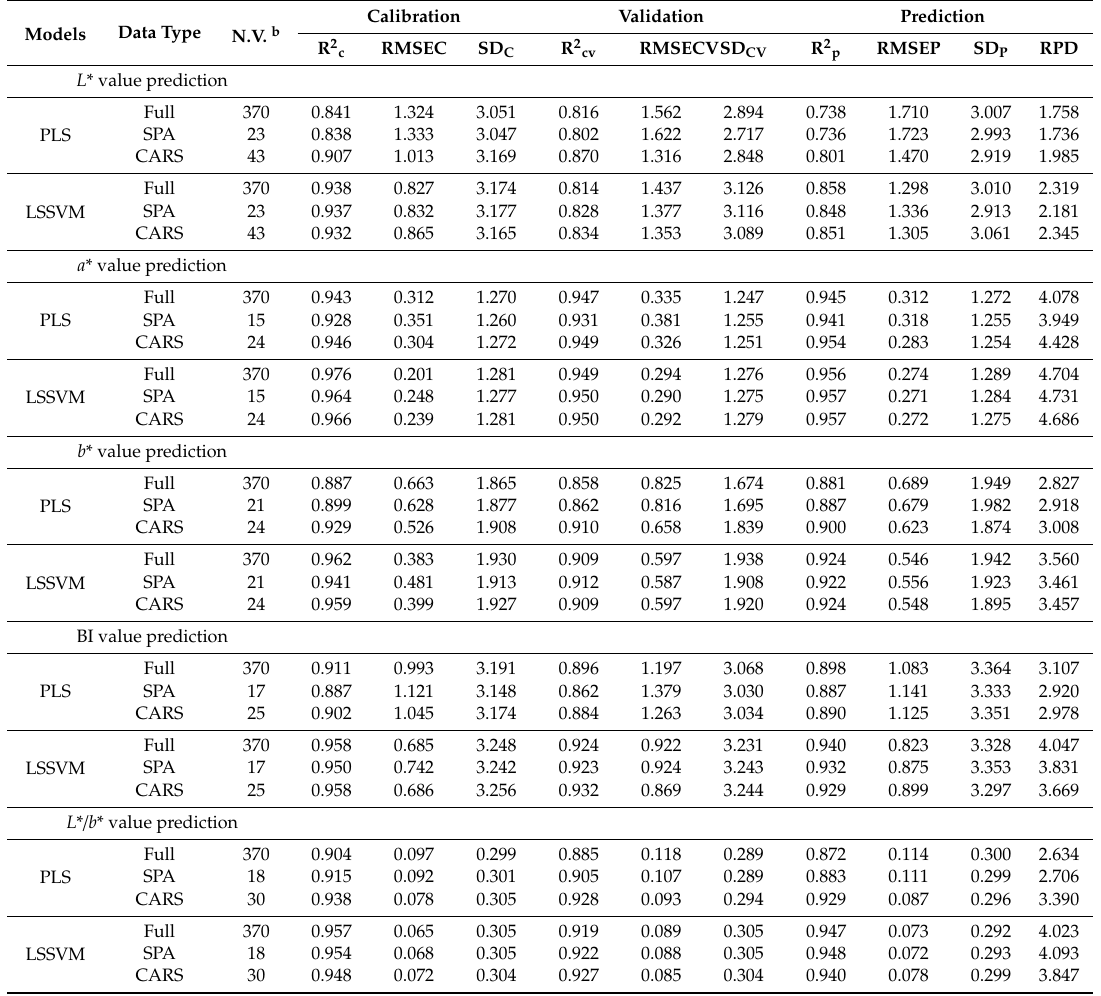
Table 2. Prediction results of L *, a *, b *, BI, L * / b * value by partial least squares (PLS) and least squares support vector machine (LS-SVM) models using full spectra, wavelengths selected by successive projections algorithm (SPA) and competitive adaptive reweighted sampling